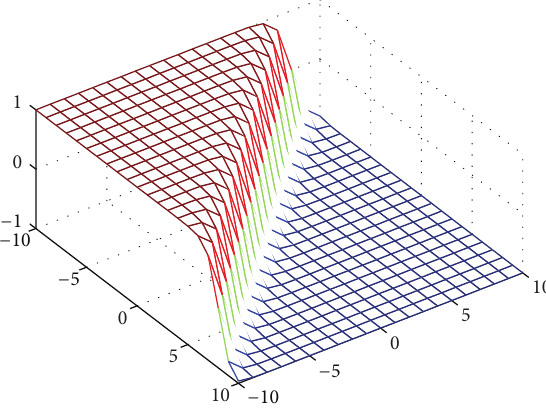
Figure 1: The form of Rossby solitary wave at 𝑡 = 1 , wave speed 𝑐 = −2